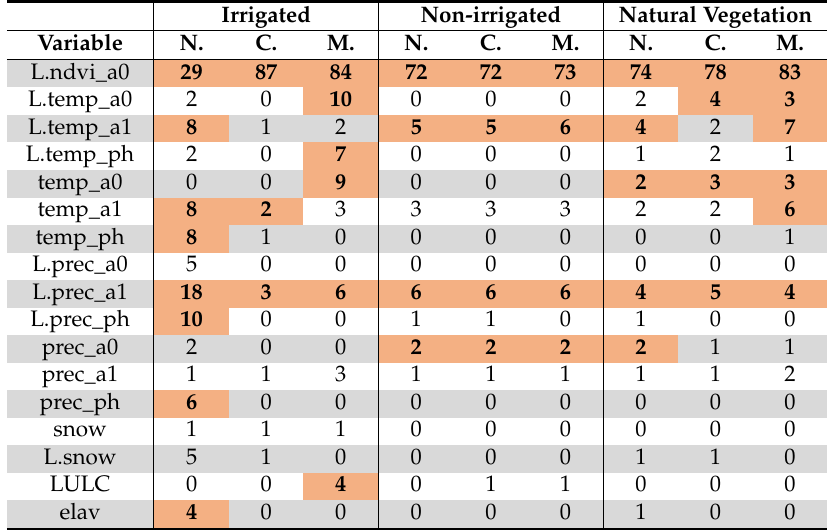
Table 2. Variable effect magnitude expressed as partial eta-squared ( η 2 ) values for the calculated models. Irrigated Non-irrigated Natural Vegetation